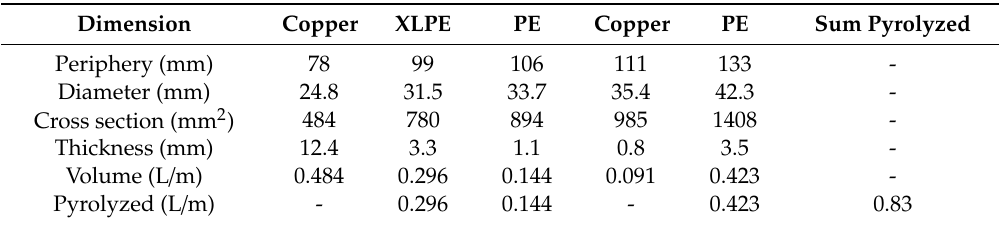
Table 1. Materials pyrolyzed from the TXSP 6 / 10 (12) kV in the reactor cabinet.